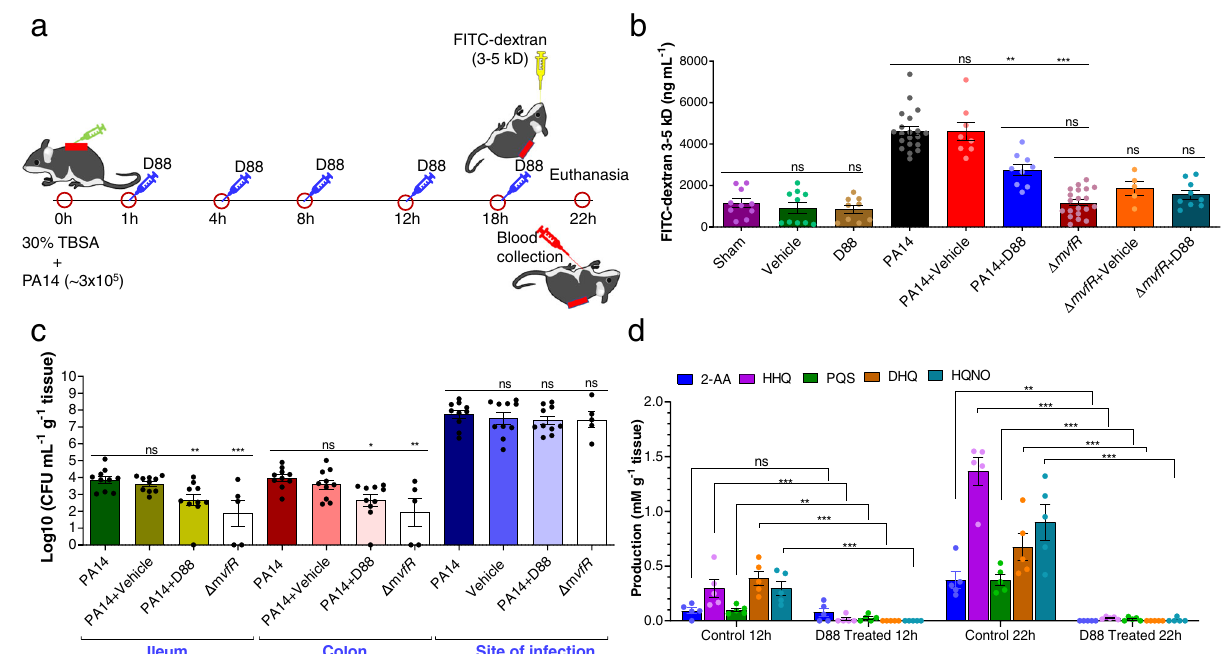
Fig. 6 | MvfR promotes intestinal permeability. Its pharmacologic inhibition mitigates the host intestinal barrier damage, ameliorates bacterial dis- semination, and abolishes the production of the small molecules. a Schematic representation of the burn-site infection model and treatment plan. The color of syringesindicatesadministration:Greenbacterialinoculum;blueD88;yellowFITC- dextran; and red blood collection. b Fluorescein Isothiocyanate-Dextran (FITC- dextran) 3-5kDa levels in the serum 22h post-infection. FITC-dextran 3-5kDa was gavaged 18hr post-burn and infection. Blood was collected 4h following gavage (22h post-burn and infection), and the FITC-dextran fl uorescence intensity was measuredusing fl uorescentspectrophotometry(excitation,480nm,andemission, 520nm). c Effect of D88onthe bacterialdissemination to the ileumand colon and bacterial load at the site of infection. Small and large intestinal tissues and muscle underlying the burn eschar and infection site from mice of each group were col- lected at 22h post-burn and infection. Sample homogenates were serially diluted